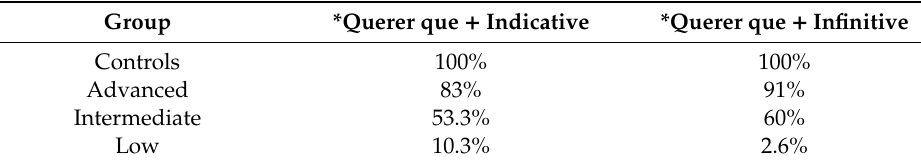
Table 3. Percentage of rejections of unacceptable structures.